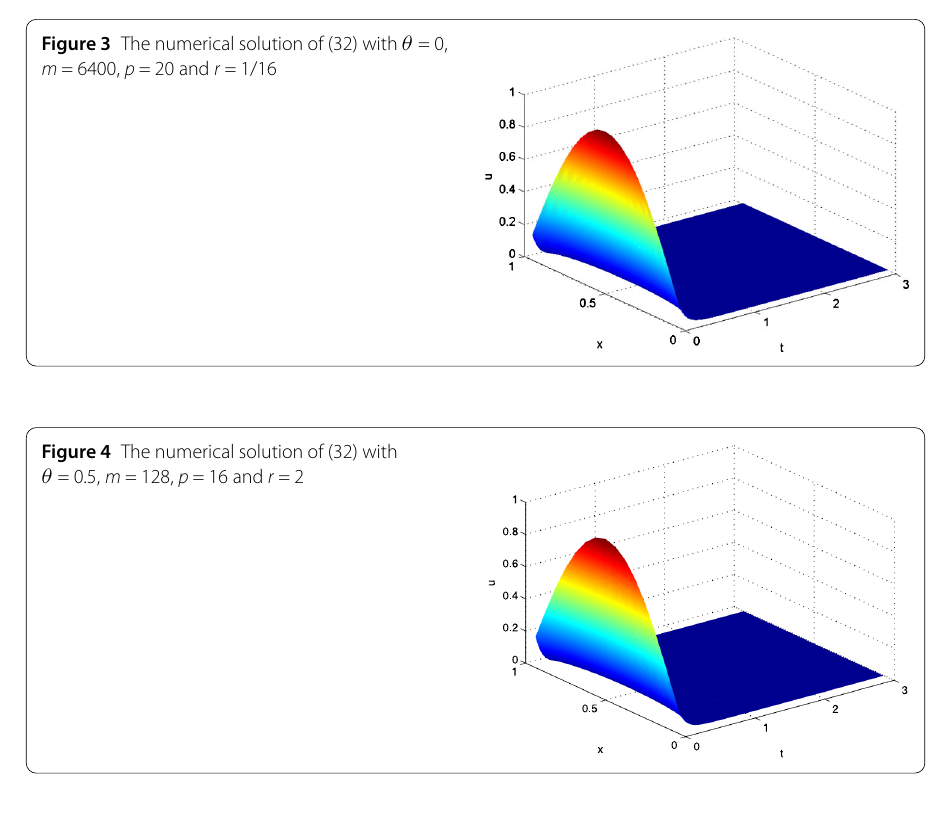
Figure 3 The numerical solution of (32) with θ = 0, m = 6400, p = 20 and r = 1/16